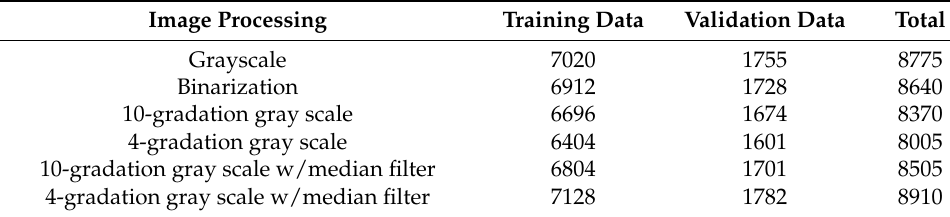
Table 9. Deep learning CNN dataset.